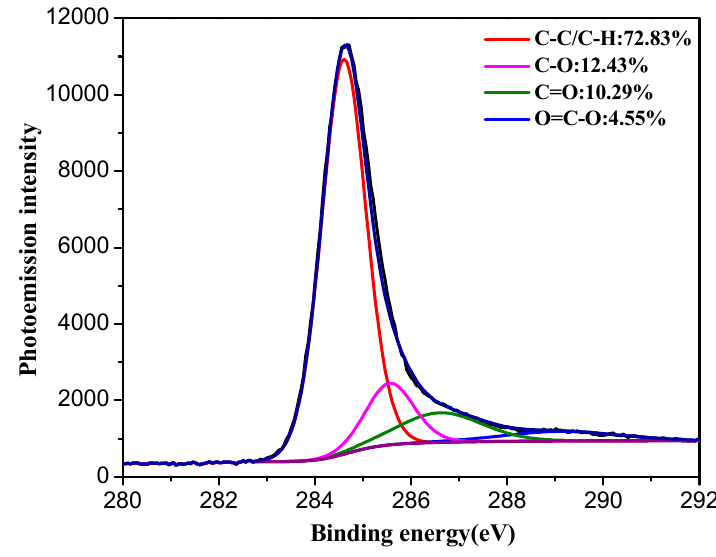
Figure 2. Cls peak of oxidized coal.